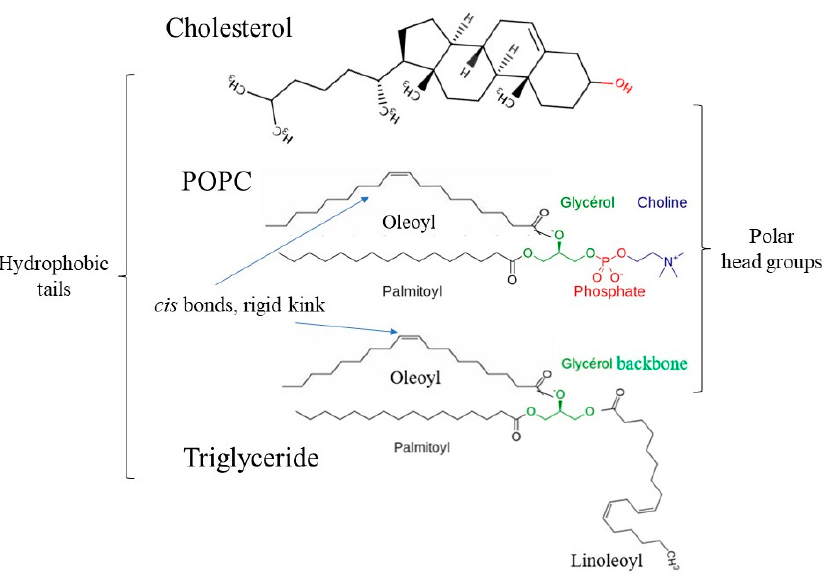
Figure 1. Chemical structure of three egg yolk lipids.